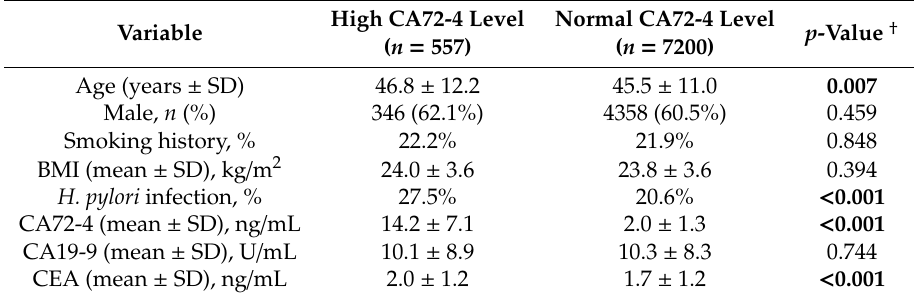
Table 2. Clinical risk factors of gastric cancer (GC) and tumor markers in high and normal CA72-4 level